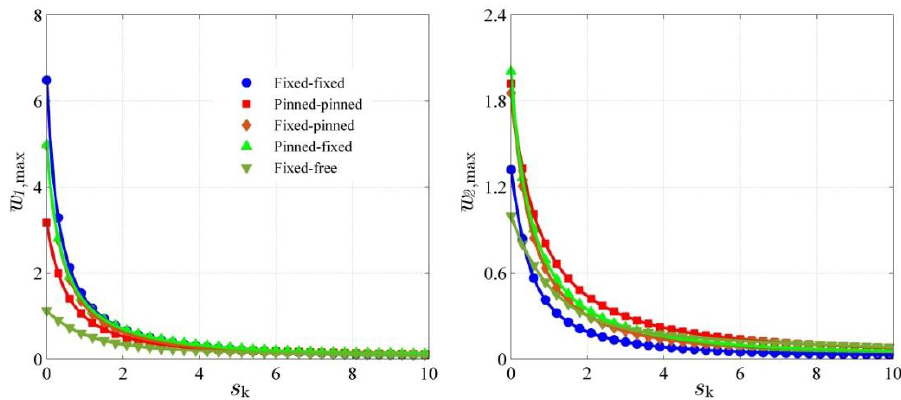
Figure 17. Maximum displacement ratios 𝑤̅ 1,max and 𝑤̅ 2,max versus mass ratio 𝑠 k for different boundary conditions when 𝛼 = 0.5 , 𝑠 e = 100 and 𝑠 m = 1 .